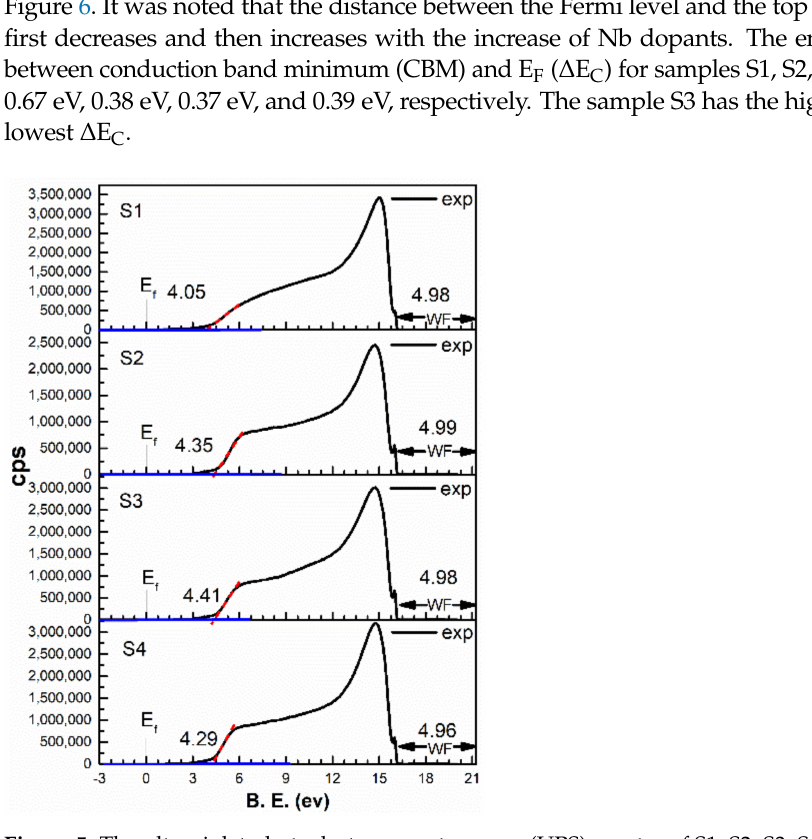
Figure 5. The ultraviolet photoelectron spectroscopy (UPS) spectra of S1, S2, S3, S4 samples.